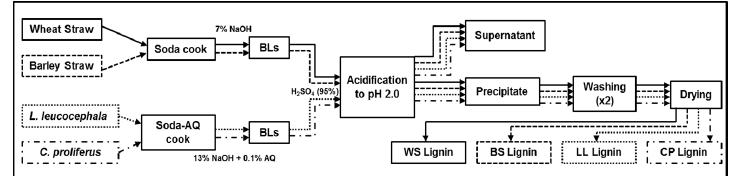
Figure 1. Scheme of lignin isolation. AQ, Anthraquinone; BLs, black liquors; WS, wheat straw; BS, barley straw; LL, Leucaena leucocephala ; CP, Chamaecytisus proliferus .